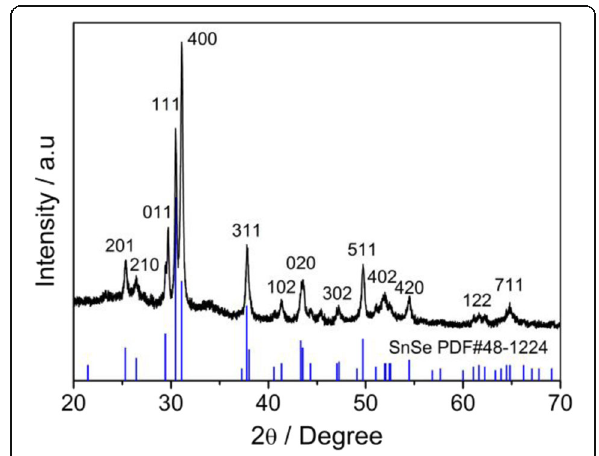
Fig. 1 The XRD pattern of the SnSe-graphene